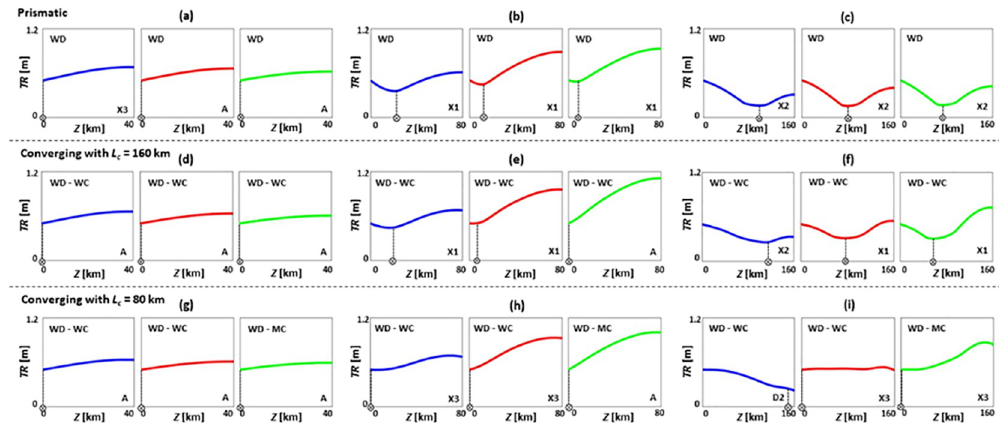
Fig 5. Tidal range TR patterns of prismatic (a-c), converging with L c = 160 km (d-f), and converging with L c = 80 km (g-i) estuaries under SLR, where TR = 0.5 m, Q / TP = 5% (medium river discharge), n = 0.015 s/m 1/3 , h = 5 m, and θ = 0˚. (a), (d), 0 and (g) are short estuaries ( Z = 40 km); (b), (e), and (h) are moderate estuaries ( Z = 80 km); and (c), (f), and (i) are long estuaries ( Z = 160 km). Blue, red, and green colours show base case (no SLR), 1 m of SLR, and 2 m of SLR scenarios, respectively. Patterns A, X1, X2, X3, D1, and D2 are the general TR patterns introduced in Fig 2. WD, WC, and MC refer to weakly dissipative, weakly converging, and moderately converging estuaries,